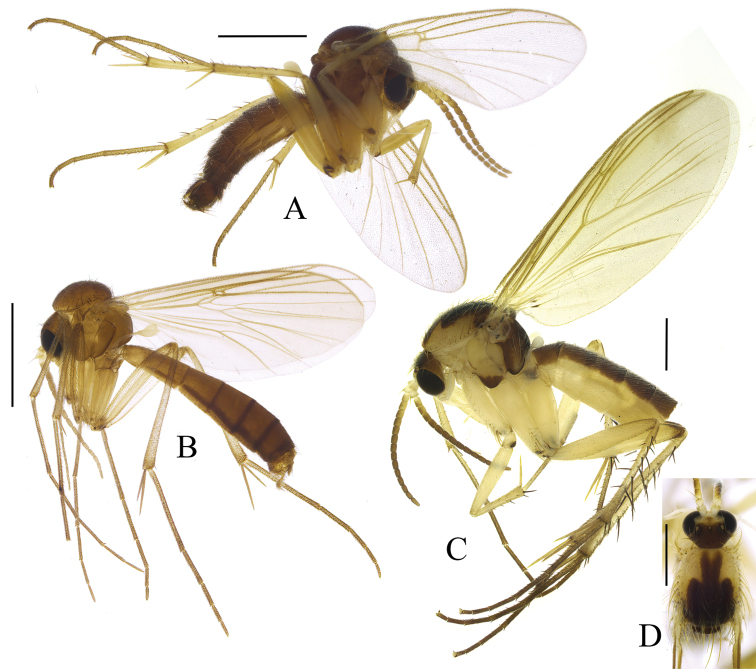
Habitus photos of new species ASciophila
georgei sp. nov., paratype BAnatella
metae sp. nov., paratype CLeia
katae sp. nov., holotype, terminalia detached. Scale bars: 1 mm.